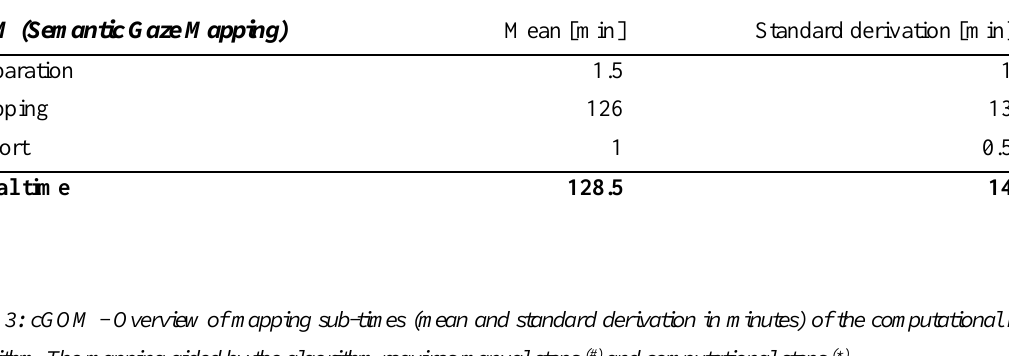
Table 2: SGM - Overview of the mapping sub-times (mean and standard derivation in minutes) of the manual mapping by five professional analysts. The sub-tasks were preparation, mapping and export of the data sample.